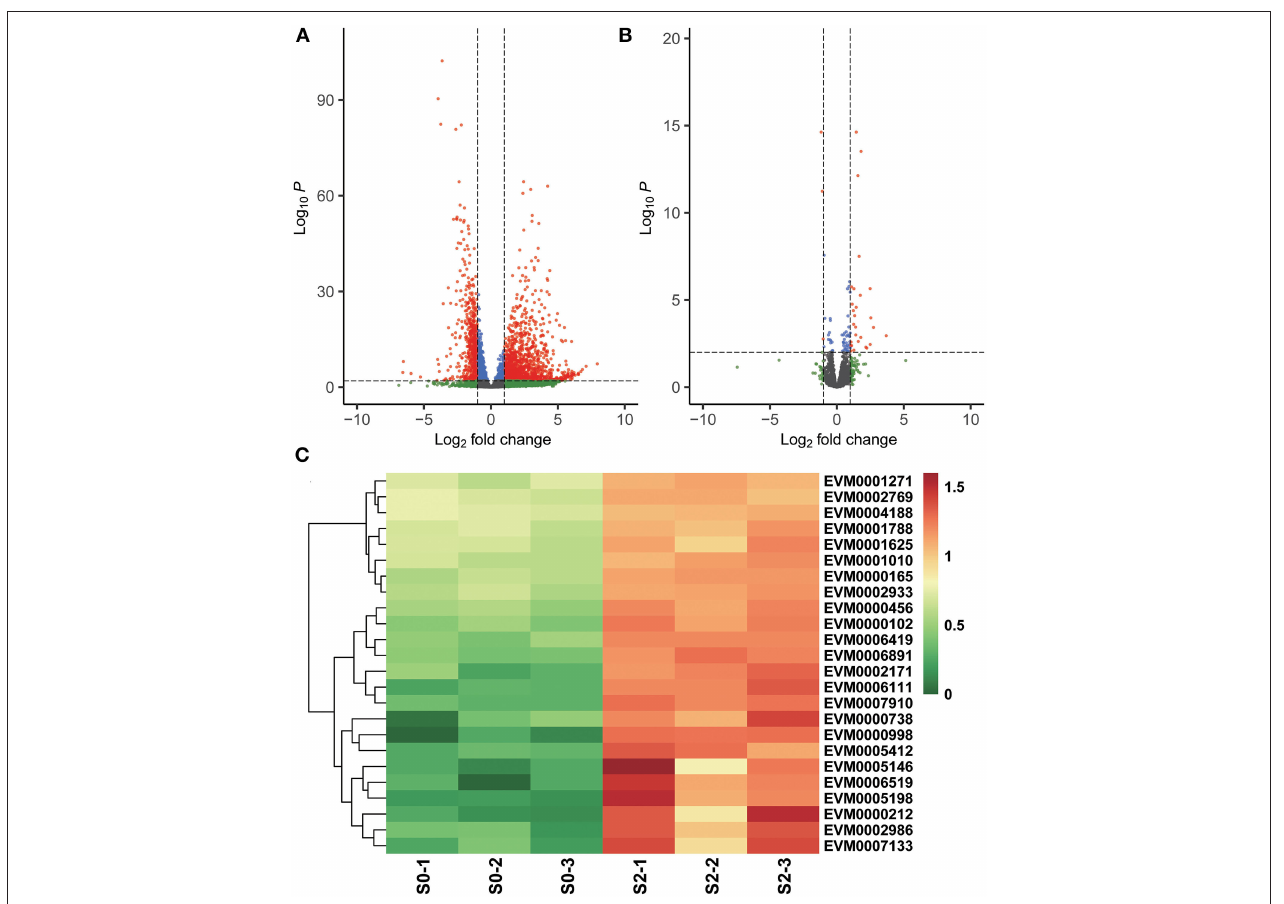
FIGURE 3 | Differential gene expression after 2h of monensin treatment. Volcano plots showing differentially expressed genes in the monensin-sensitive ETH-S strain (A) and the monensin-resistant ETH-R strain (B) after 2h of monensin treatment. Genes with an absolute fold change > 2 and adjusted p < 0.01 were considered significantly differentially expressed (red dots). (C) Heatmaps showing differentially expressed genes associated with ubiquitin and proteasome in the monensin-sensitive ETH-S strain after 2h of monensin treatment. For heatmap drawing, gene expression levels were transformed into normalized log 2 (TPM +